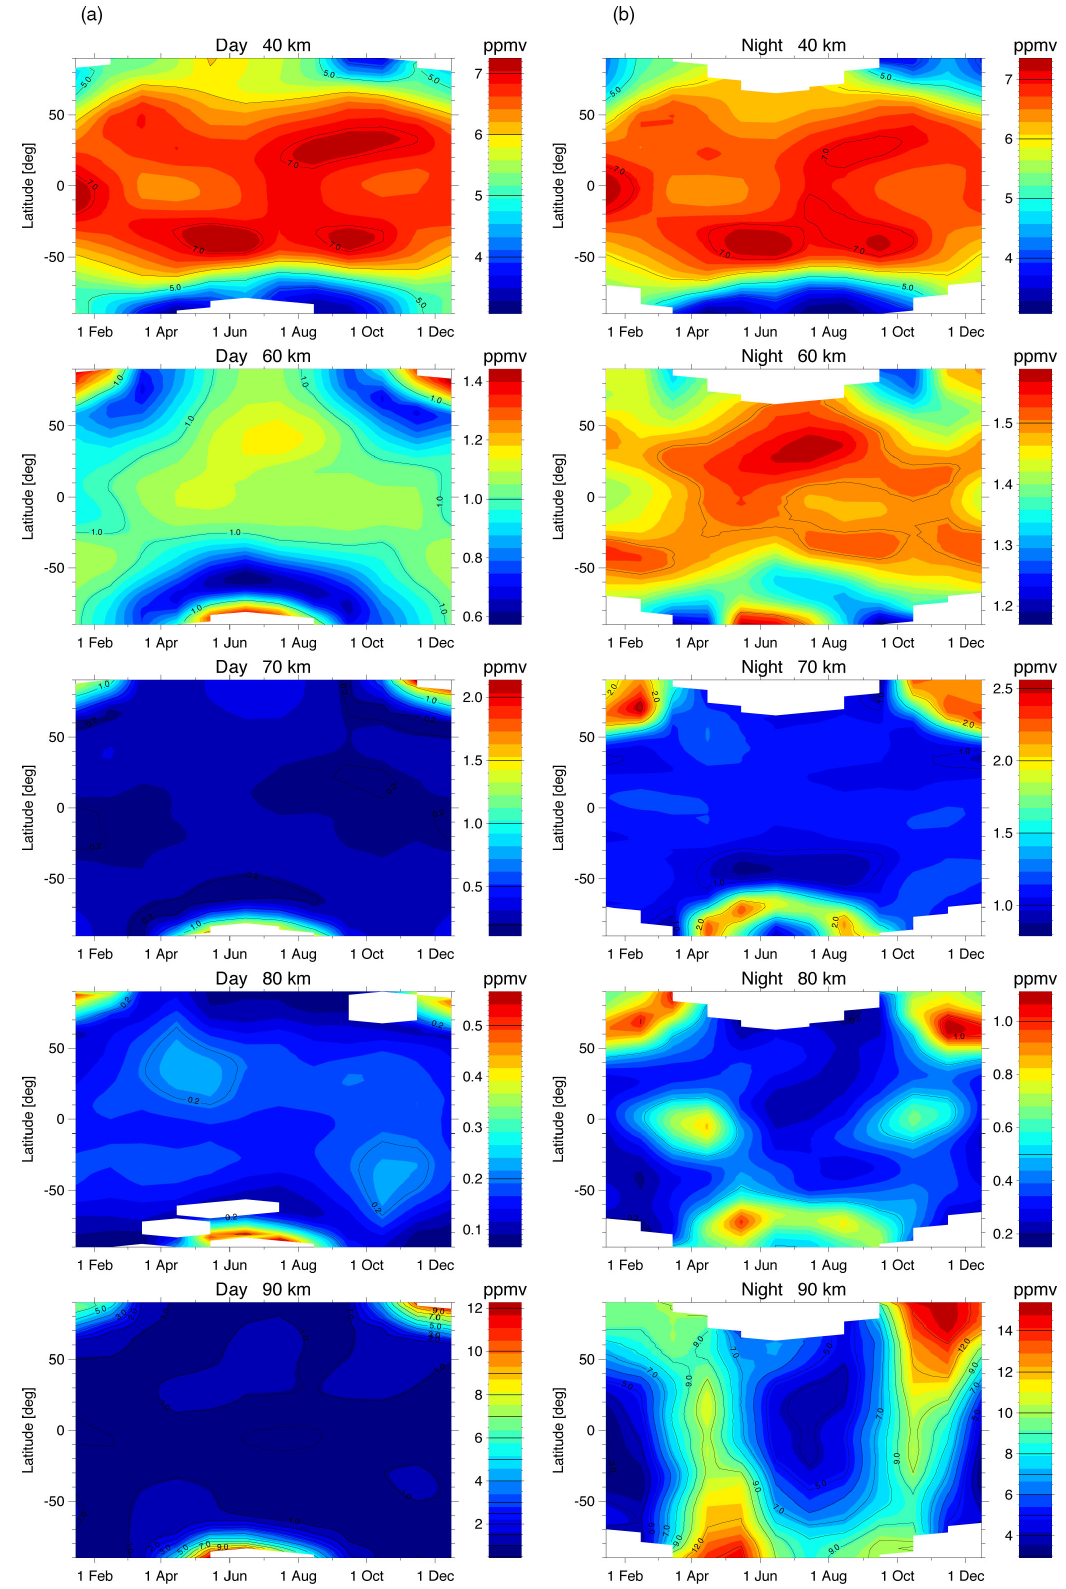
Figure 14. Seasonal evolution vs. latitude of O 3 VMR at different altitudes for daytime (a) and nighttime (b) . Note the different scales used in the different